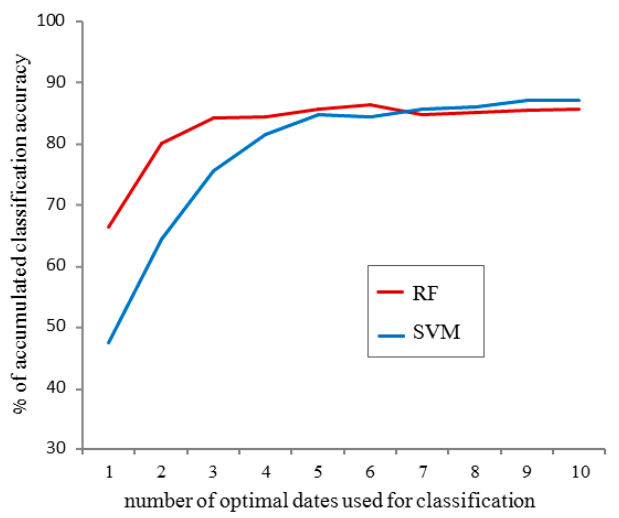
Figure 6. Total classification accuracy of the near-surface time series using random forest or support vector machine. The classification was carried out using all spectral indices from the Sataf southern-facing site (S ′ S) observations ( 708 individuals, 11 species). The differences in classification accuracy between the four sites were small (Figure 7).